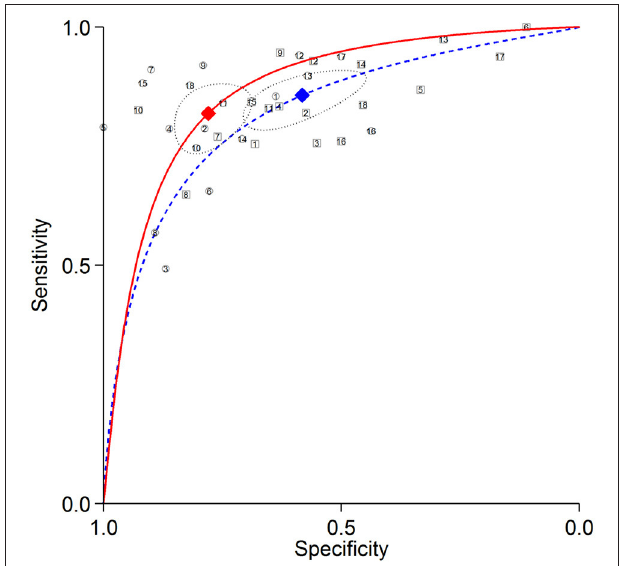
FIGURE 4 | Summary ROC curves of detecting LCX stenosis. Comparisons of summary ROC curves between all AC (solid line) vs. all NAC (dashed line). Each circle (AC) and square (NAC) represent an individual included study. Diamonds represent summary operating points of pooled sensitivity and specificity. AC, attenuation correction; CAD, coronary artery disease; LCX, left circumflex artery; NAC, non-AC; ROC, receiver operating characteristic.